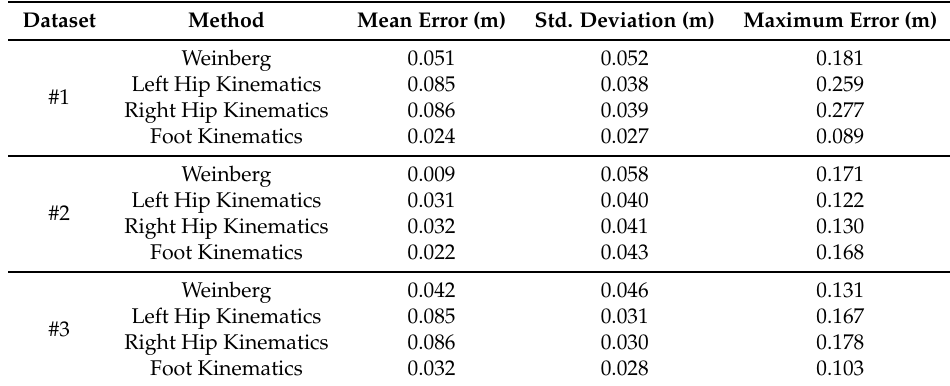
Figure 15. Step length error distributions between different methods. Table 4. Step length error